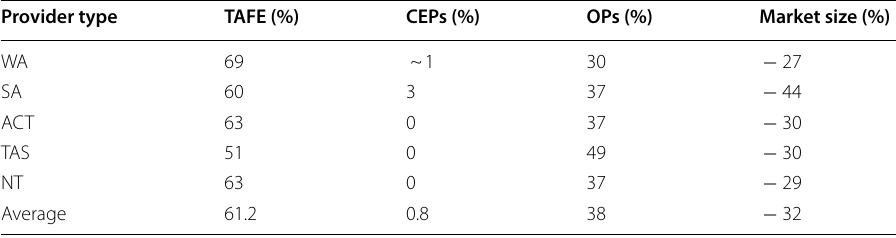
Table 4 % market share in 2020 and reduction of government-funded market participants Provider